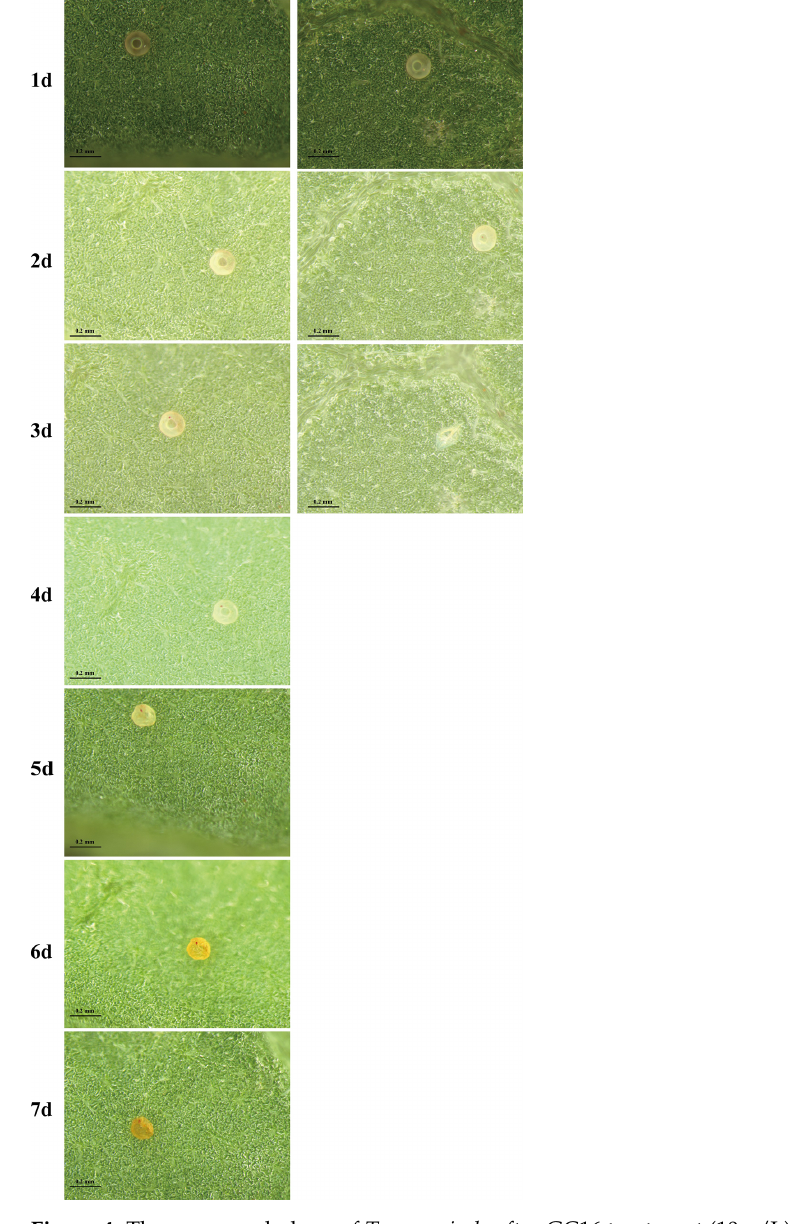
Figure 4. The egg morphology of T. pueraricola after GC16 treatment (10 g/L) vs. Control